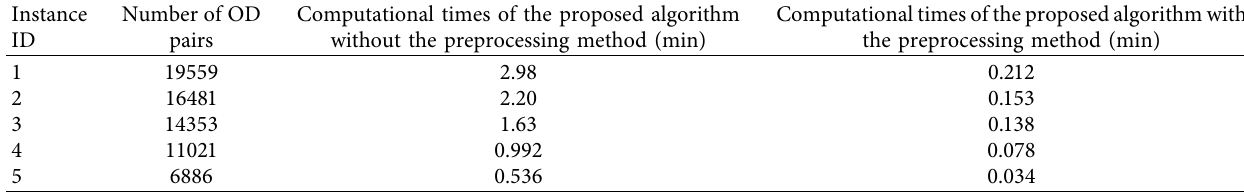
Table 9: Comparison of the computational efficiency under different network sizes.